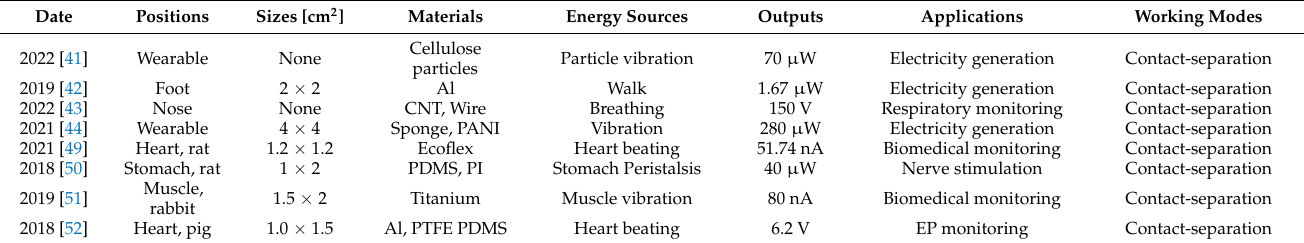
Table 1. Summary of parameters of wearable and implantable